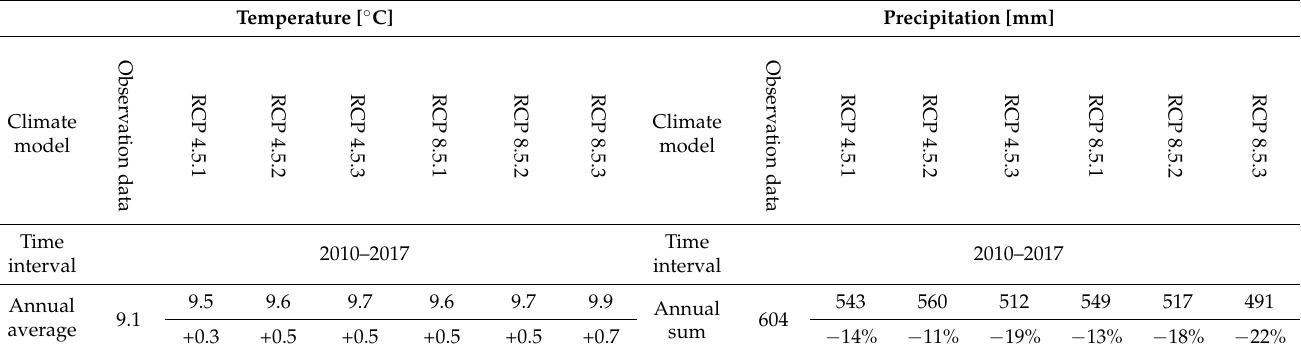
Table 5. Validation of meteorological data (temperature and precipitation) (own